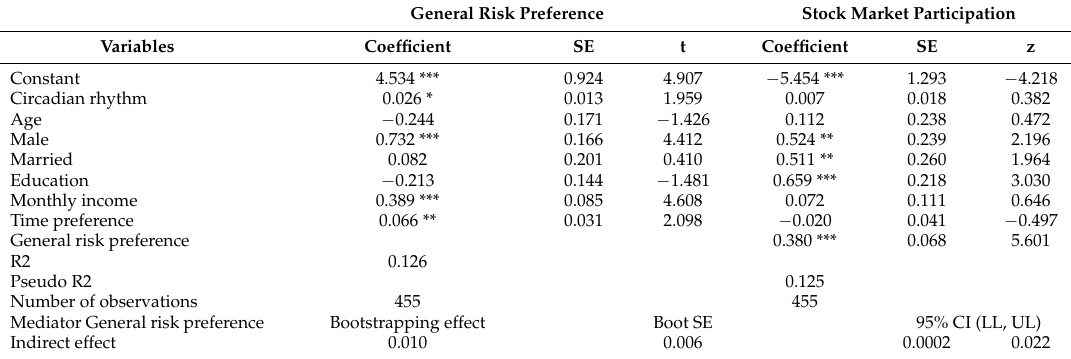
Table A4. The mediating effect of general risk preference on the relationship between circadian rhythm and stock market